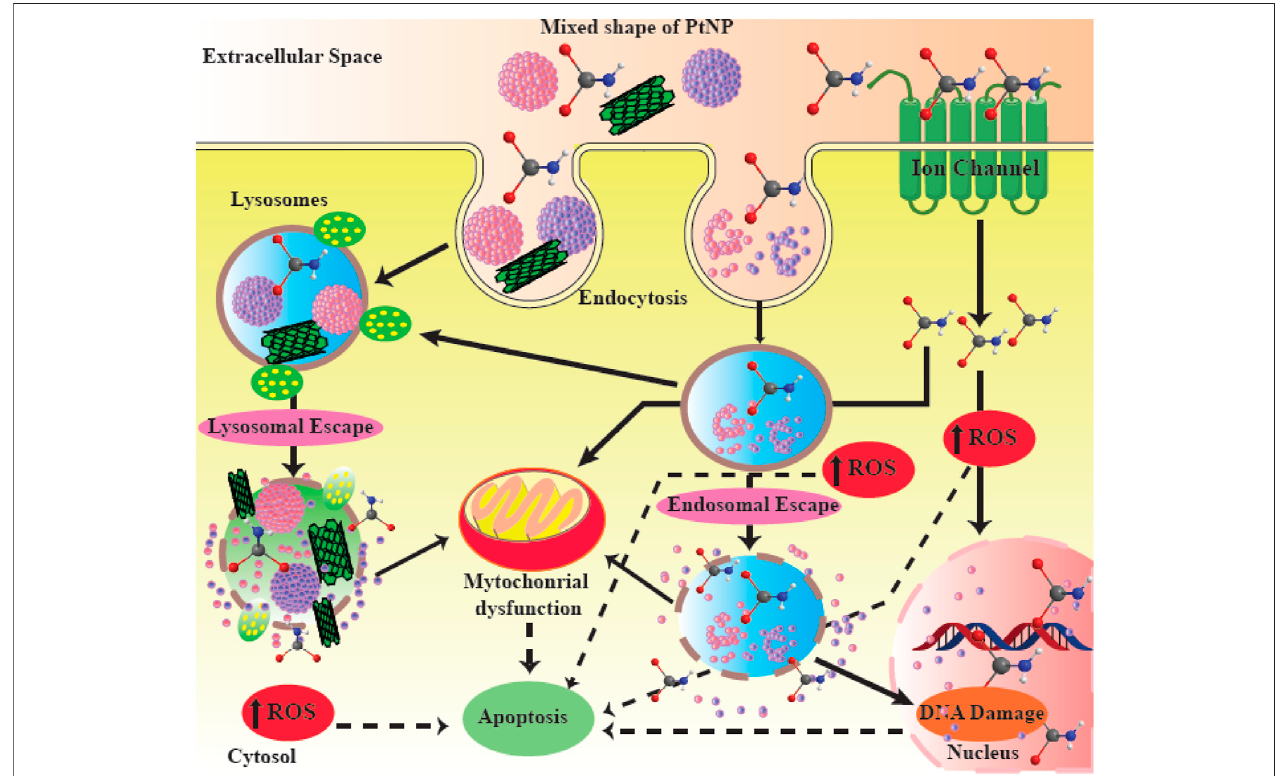
FIGURE 5 | Possible mechanisms of action of PtNPs. PtNPs are able to induce apoptosis and DNA damage in cancer cells. This fi gure adapted from Jeyaraj et al. (2019).